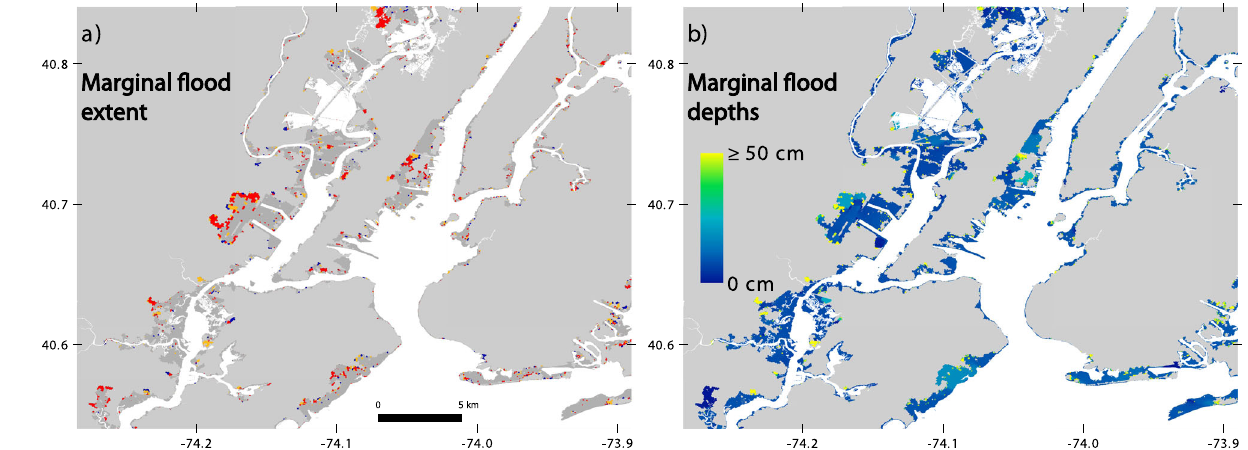
Fig. 3 The marginal effects on fl ooding contributed by different amounts of anthropogenic sea level rise (ASLR). a The estimated marginal contributions to fl ood extent for three sea level differences spanning 5th – 95th percentile ASLR estimates from budget-based and semi-empirical approaches (Table 1). Hydrodynamic modeling indicates Sandy would not have fl ooded blue areas if the starting sea level had been 4 cm lower; neither blue nor orange areas if 10 cm lower; and neither blue, orange nor red areas if 20 cm lower. The slightly darkened gray areas would have fl ooded in any of these cases. b The estimated marginal contribution to fl ood depths for the sea level difference closest to the median total ensemble ASLR estimate (10